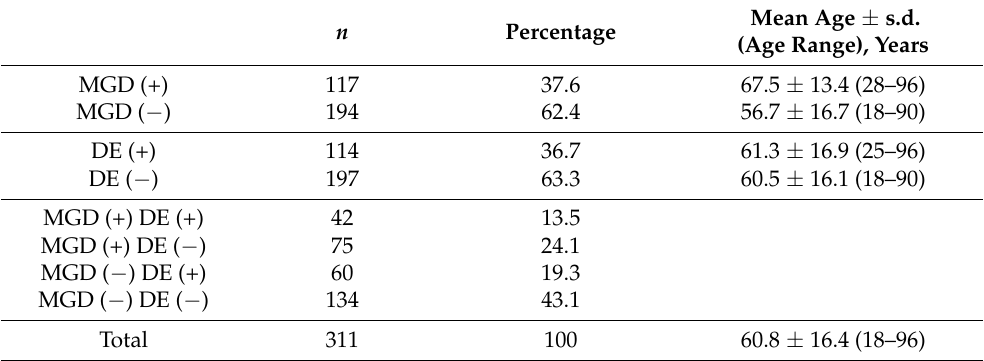
Table 2. Demographics of the study subjects according to diagnoses of meibomian gland dysfunction (MGD) and dry eye (DE).